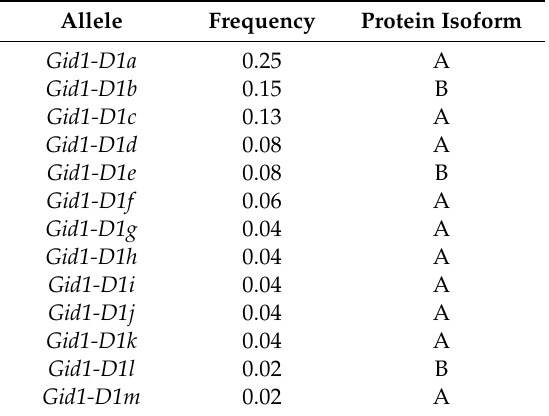
Table 3. Frequencies of the Gid1-D alleles within the studied collection of Ae. tauschii accessions and corresponding protein